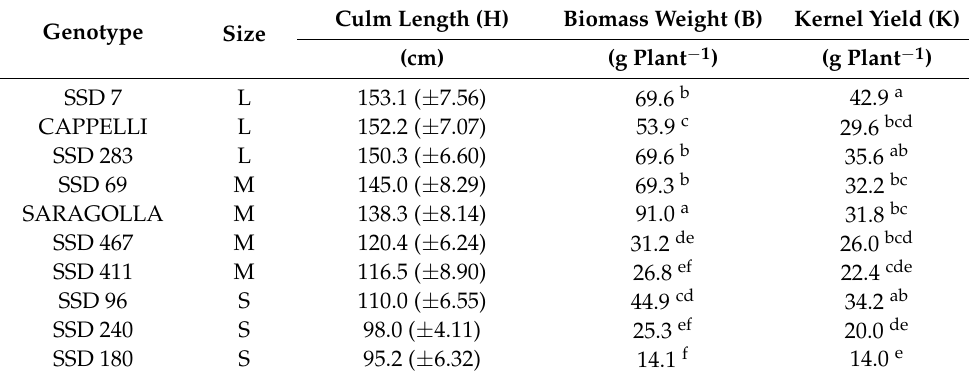
Table 2. Phenotypic traits. Culm length ( ± SD are reported in brackets), biomass weight, and kernel yield were determined at complete ripeness stage. Data are calculated as the average of ten replicates.